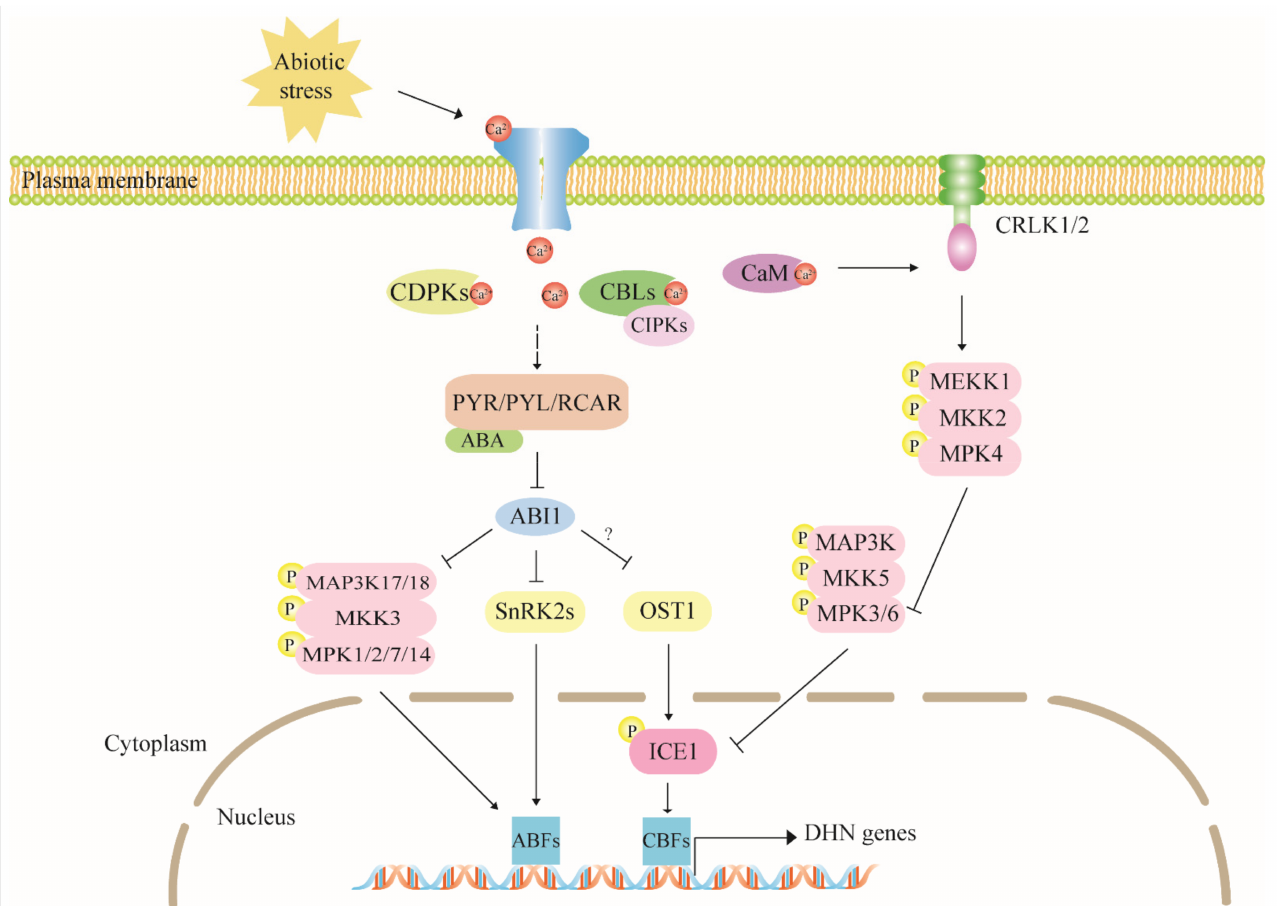
Figure 4. The MAPK cascade pathway is an upstream regulator of dehydrin gene expression. Under drought conditions, MAP3K-MKK3-MPK1/2/7/14 is activated by the core ABA component and regulates the expression of downstream dehy- drins including RD29B and RAB18 by phosphorylating ABF TFs. In response to chilling, the MEKK1-MKK2-MPK4 cascade pathway is activated by Ca-CaM, counteracts the inhibitory effect of MAPK3/6 on ICE1, and upregulates downstream CORs . OST1 involved in the ABA signaling pathway can phosphorylate ICE1 to prevent its degradation and induce its accumulation. However, it is unclear whether ABA participates in this pathway. We use arrows and bars showing positive and negative adjustment, and solid and dashed lines indicate direct and indirect/unknown adjustment,